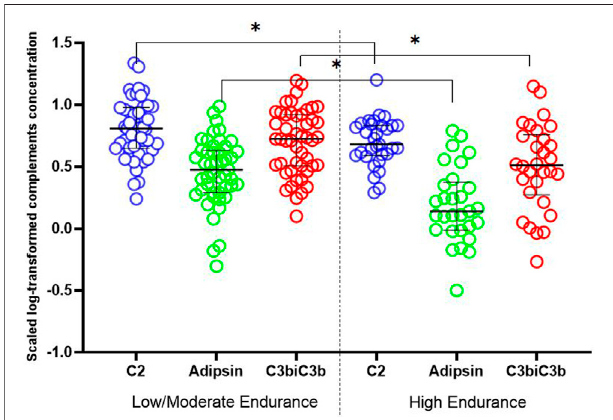
FIGURE1| Dotplotexhibitingdifferencesincomplementslevelsbetween highandmild/moderateendurancesports.Independentsample t -testwasused to compare scaled log-transformed cytokine levels ( y axis) in different sport intensity groups. Data are presented as median and IQR. * <